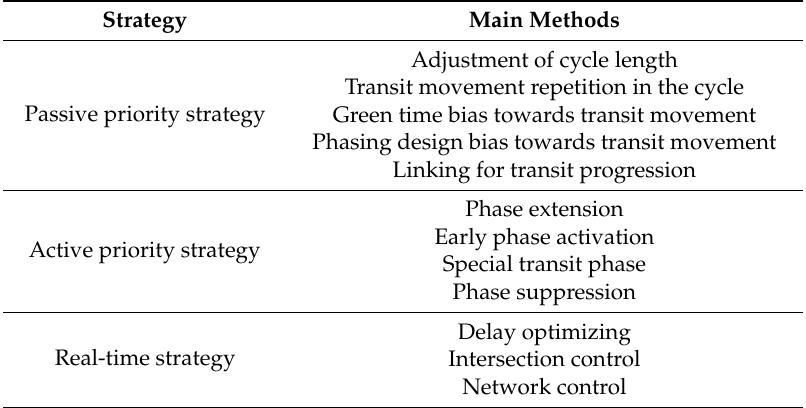
Table 1. The main strategies and methods of Transit signal priority